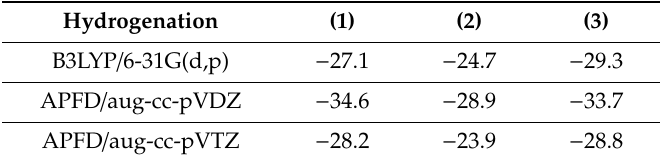
Table 5. Computed enthalpies of reaction (kcal / mol; 1.000 kcal = 4.184 kJ) for hydrogenation reactions (1)–(3) of N -methylpyrrole and its reduction products.